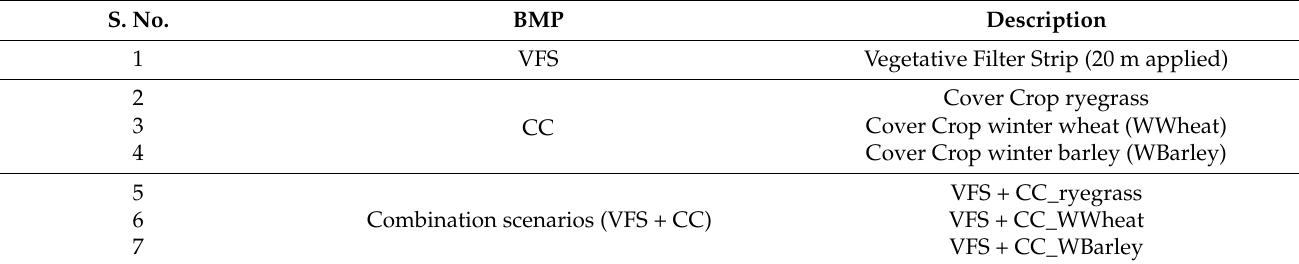
Table 1. List of BMPs applied in this